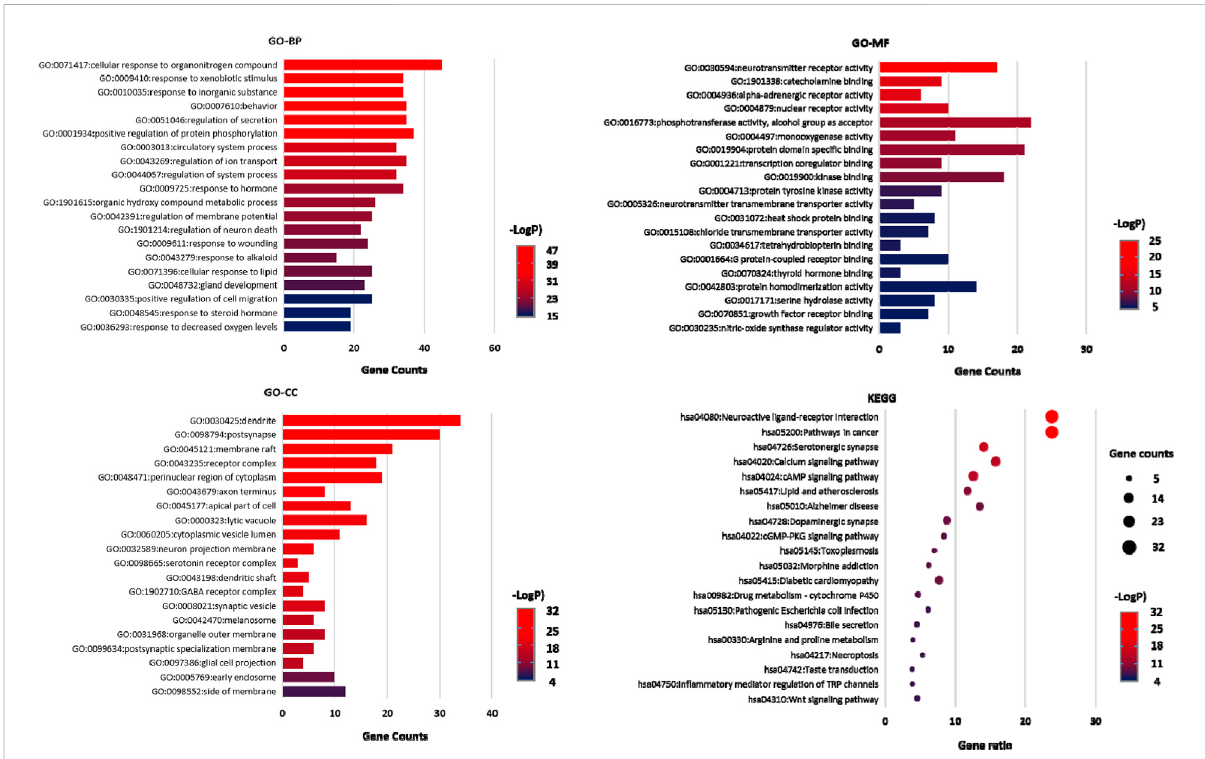
FIGURE 7 GO-BP, GO-MF, and GO-CC enrichment analysis diagram and KEGG pathway enrichment analysis